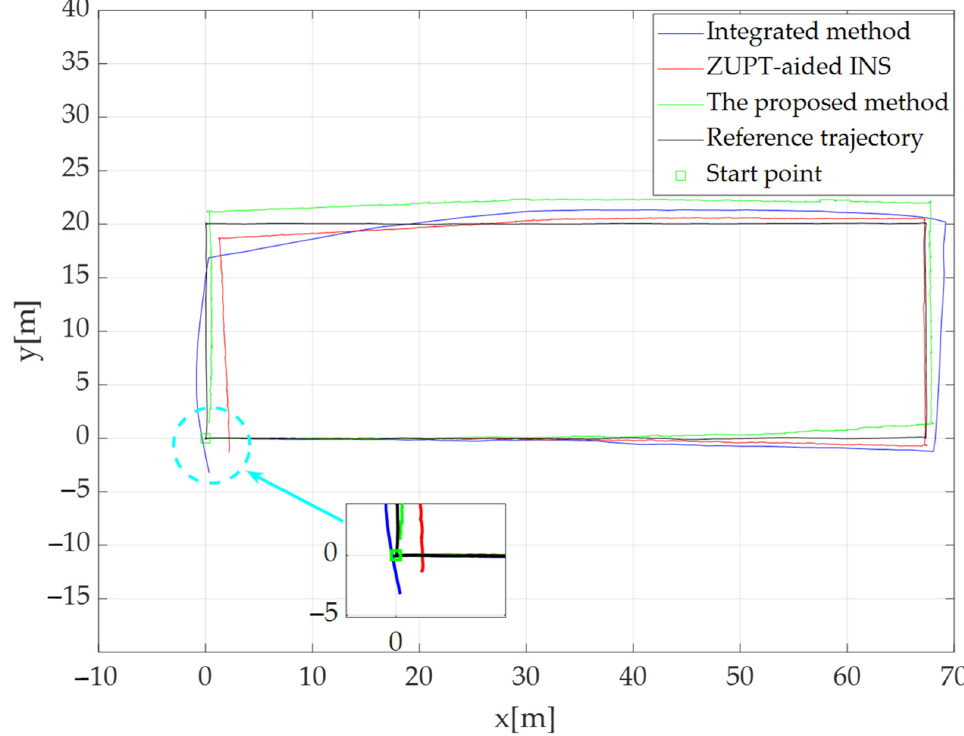
Figure 8. The 2D motion trajectory estimated by different methods.